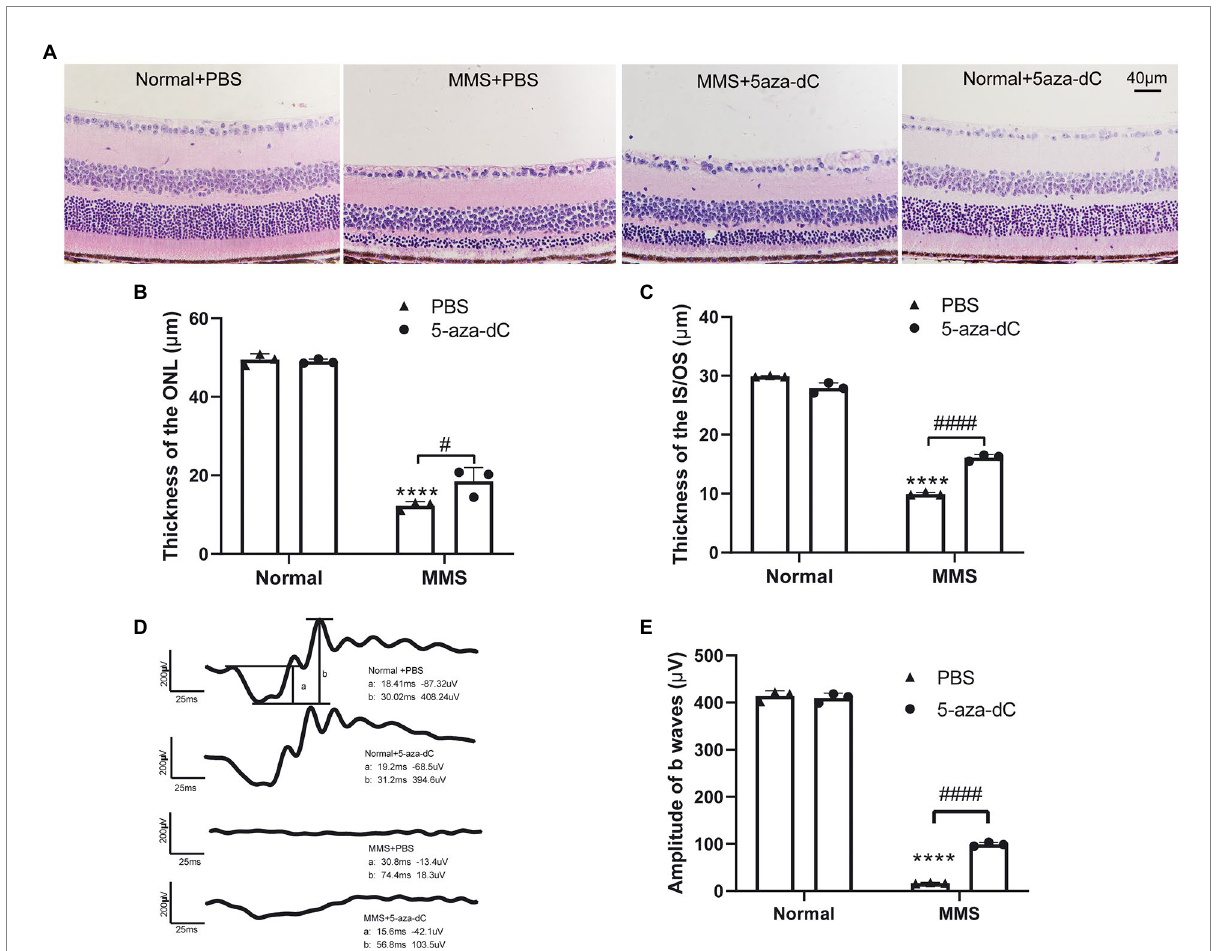
FIGURE 6 5-aza-dC attenuated the toxic effects of MMS treatment. (A) Representative H&E staining images of retina at 7 days after MMS treated mice with or without 5-aza-dC. Scale bar, 40 μ m. (B,C) The thickness of the ONL and IS/OS in the MMS + 5-aza-dC group was significantly increased than that in the MMS + PBS group. (D) Representative scotopic 3.0 ERG waveforms at 7 days after MMS treated mice with or without 5-aza-dC, scale bar: 200 μ V, 25 ms. (E) The amplitudes of b waves in the MMS + 5-aza-dC group was significantly increased than that in the MMS + PBS group. Data were expressed as mean ± SD, n = 3/group. Two-way ANOVA followed by Sidak’s post hoc test, **** p < 0.0001 for differences compared to Normal+PBS group, # p < 0.05, #### p < 0.0001 for differences between